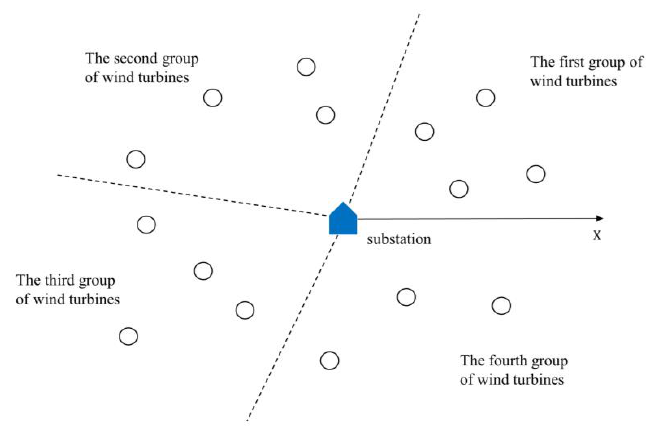
Figure 2. Schematic diagram of wind turbine grouping.